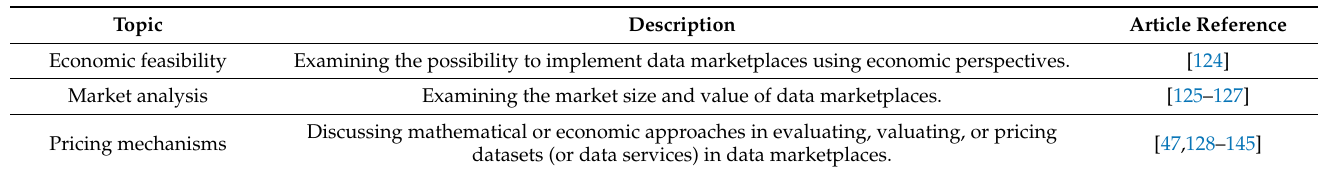
Table 5. The finance